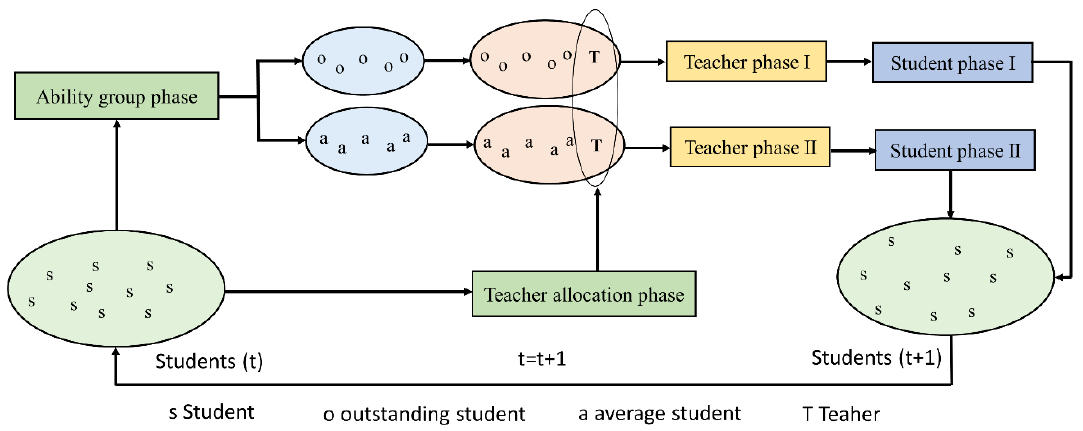
Figure 5. Phases for implementation of the group teaching optimization algorithm (GTOA).